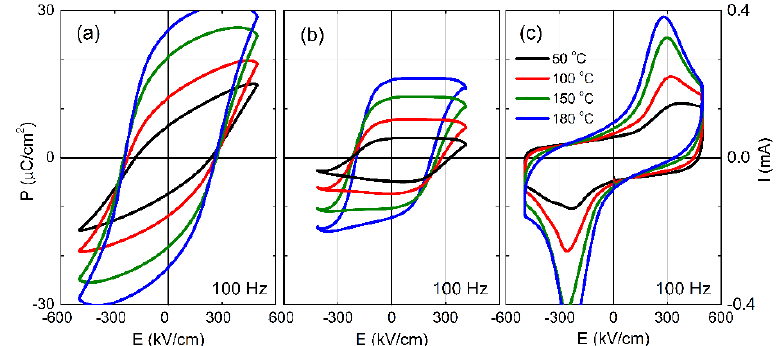
Figure 9. ( a ) Measured; ( b ) compensated dielectric hysteresis of PZT films; ( c ) current dependence of PZT film films as a function of the electrical field.